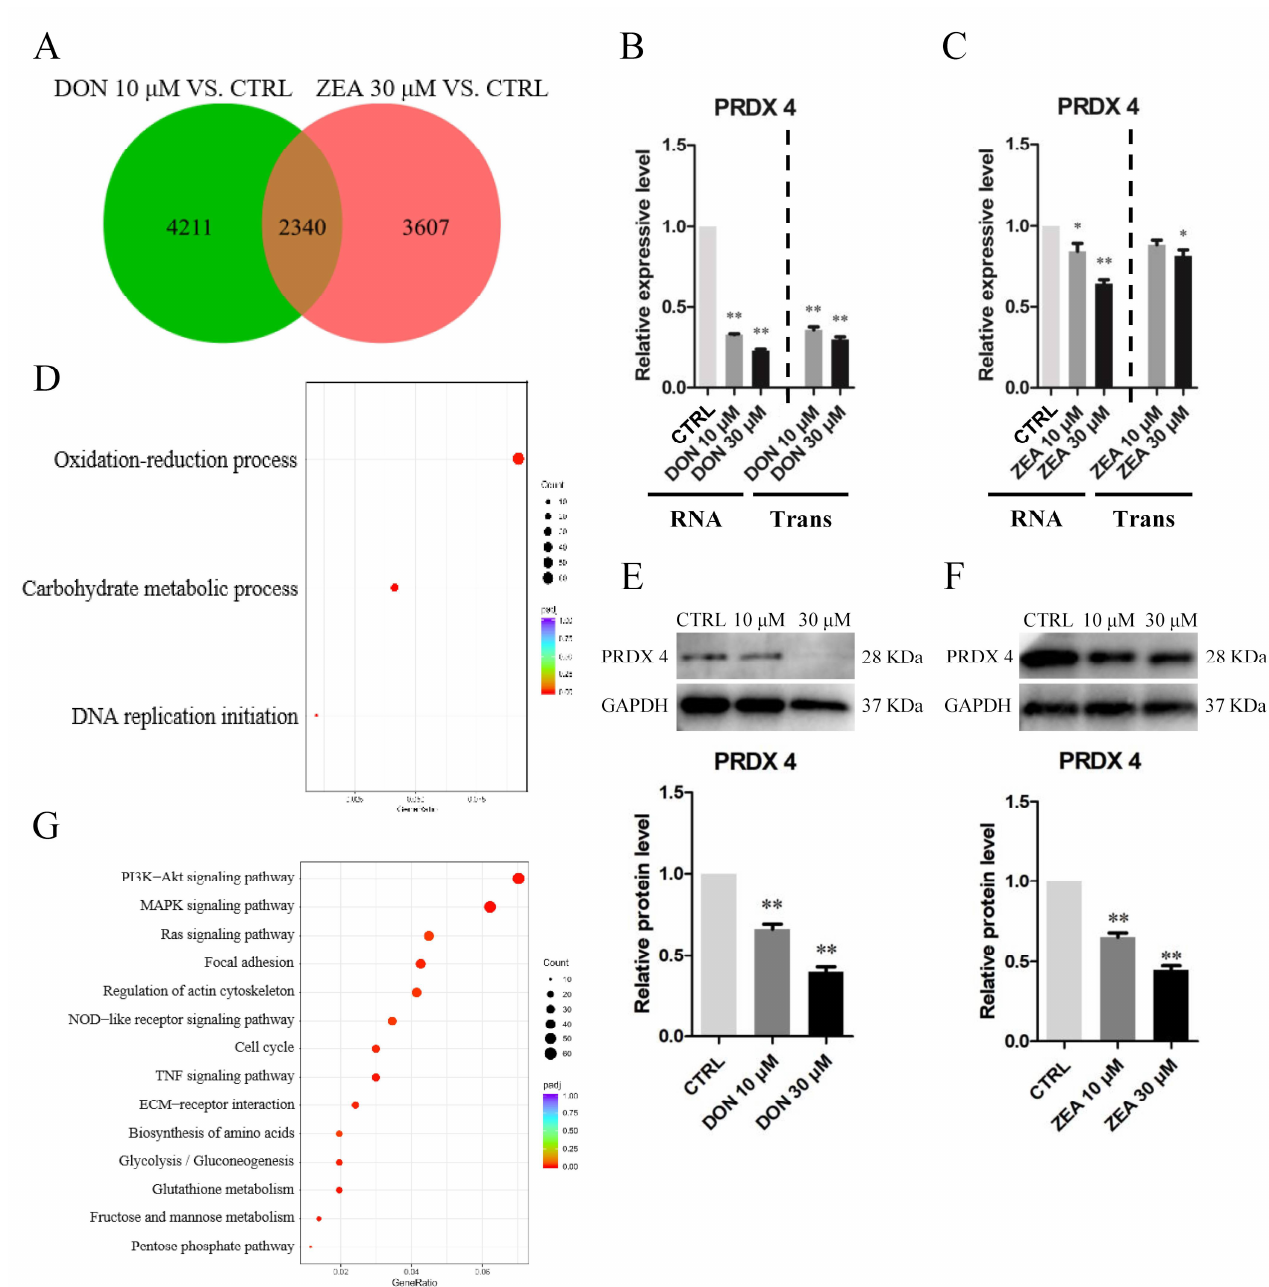
Figure 12. Gene expression of RNA-seq analysis and protein verification between the 10 µ M DON- and 30 µ M ZEA treated groups. ( A ) Venn diagram showing DEGs in SCs exposed to 10 µ M DON and 30 µ M ZEA. ( B , C ) Quantitative RT-PCR for the PRDX4 transcription factors in SCs treated with DON and ZEA. ( D , G ) GO and KEGG enrichment of 2340 DEGs in Equus asinus SCs exposed to 10 µ M DON and 30 µ M ZEA. ( E , F ) The protein levels of PRDX4 / GAPDH by Western blot in DON and ZEA treatment groups. The protein levels were normalised to GAPDH . The exposure time was 50 s. The results are presented as the means ± SD. All experiments were repeated at least three times. * p < 0.05; ** p < 0.01.